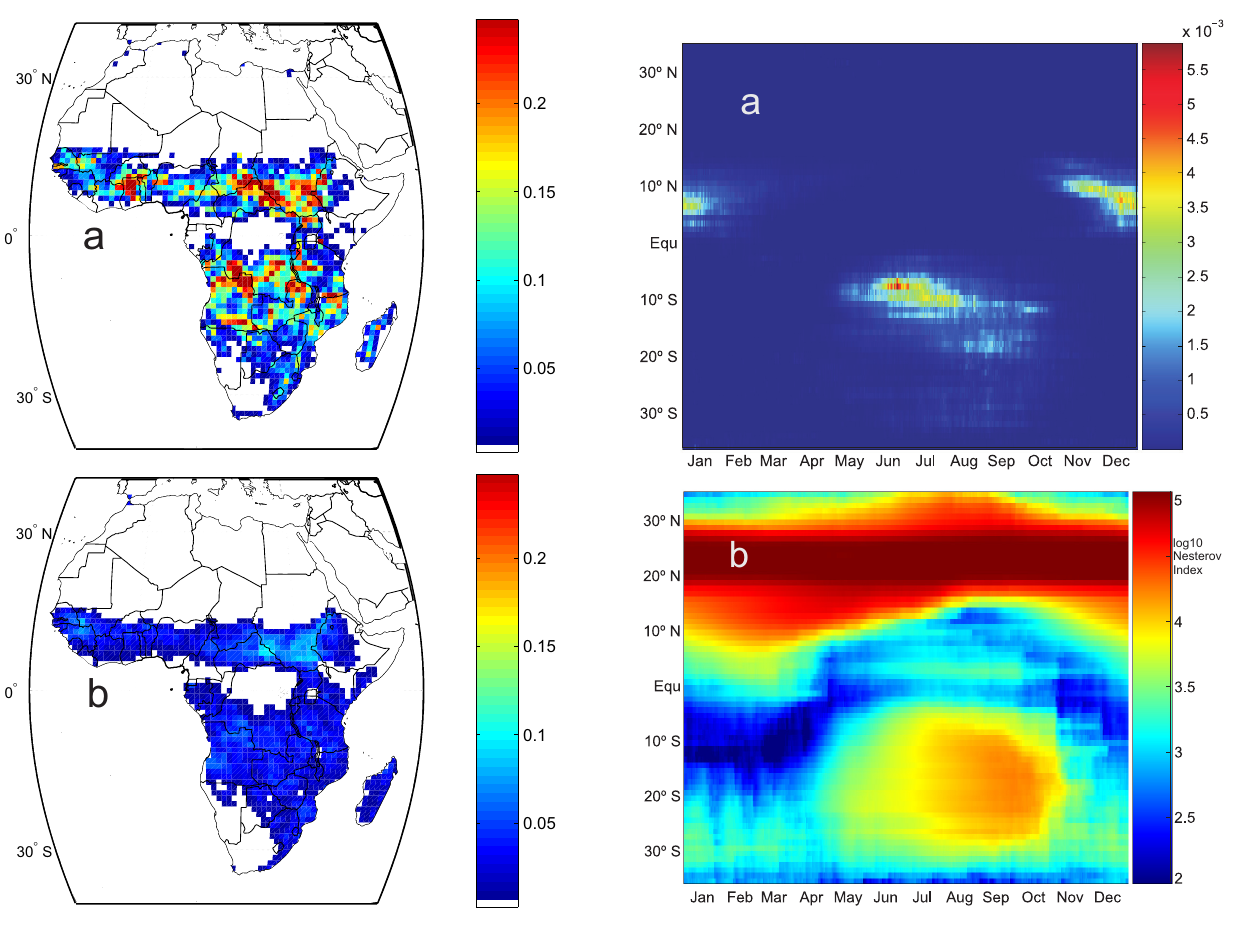
Fig. 5. Standard deviation of fraction of burned area from 2000 to 2008. Panel (a) directly derived from MODIS burned area product MCD45; panel (b) predicted from model VC, using all available years.